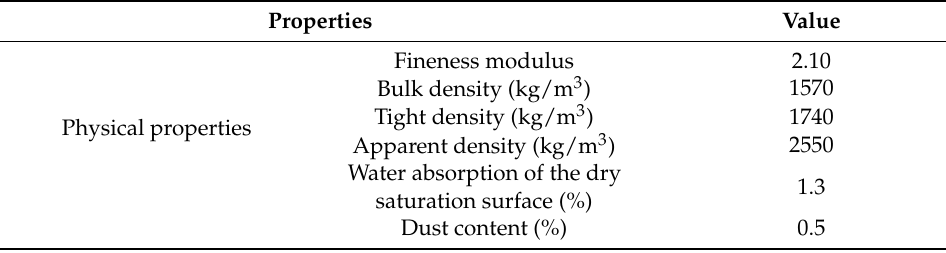
Table 3. Physical properties of natural river sand.